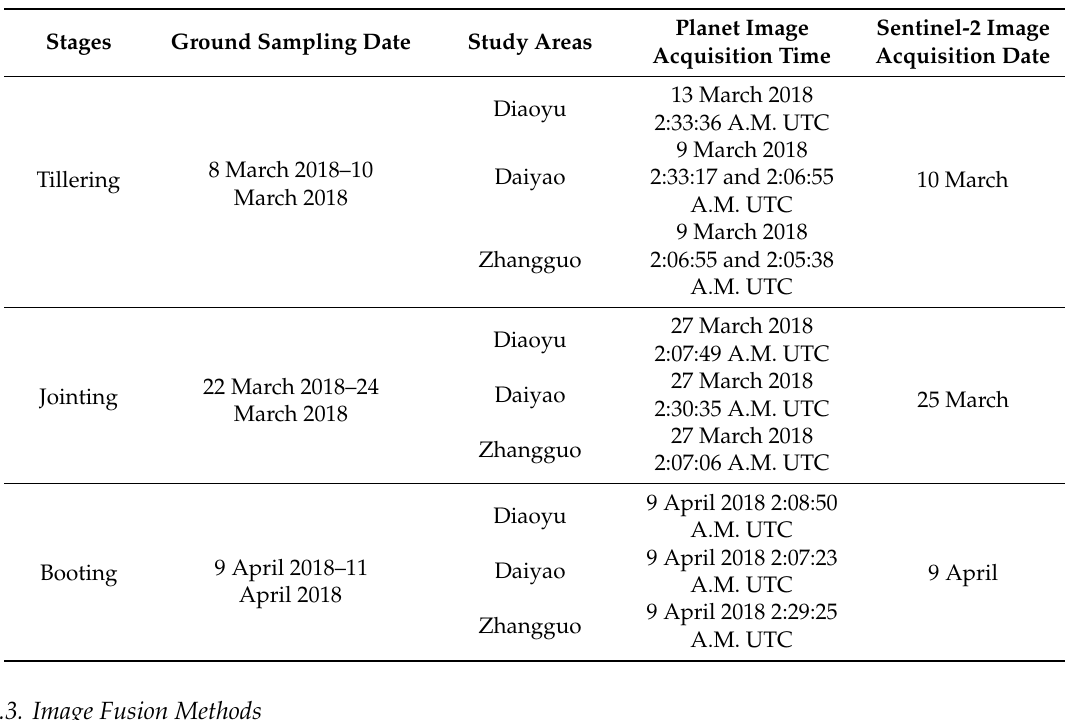
Table 3. Acquisition times for wheat samples as well as Planet and Sentinel-2 images at different crop growth stages.